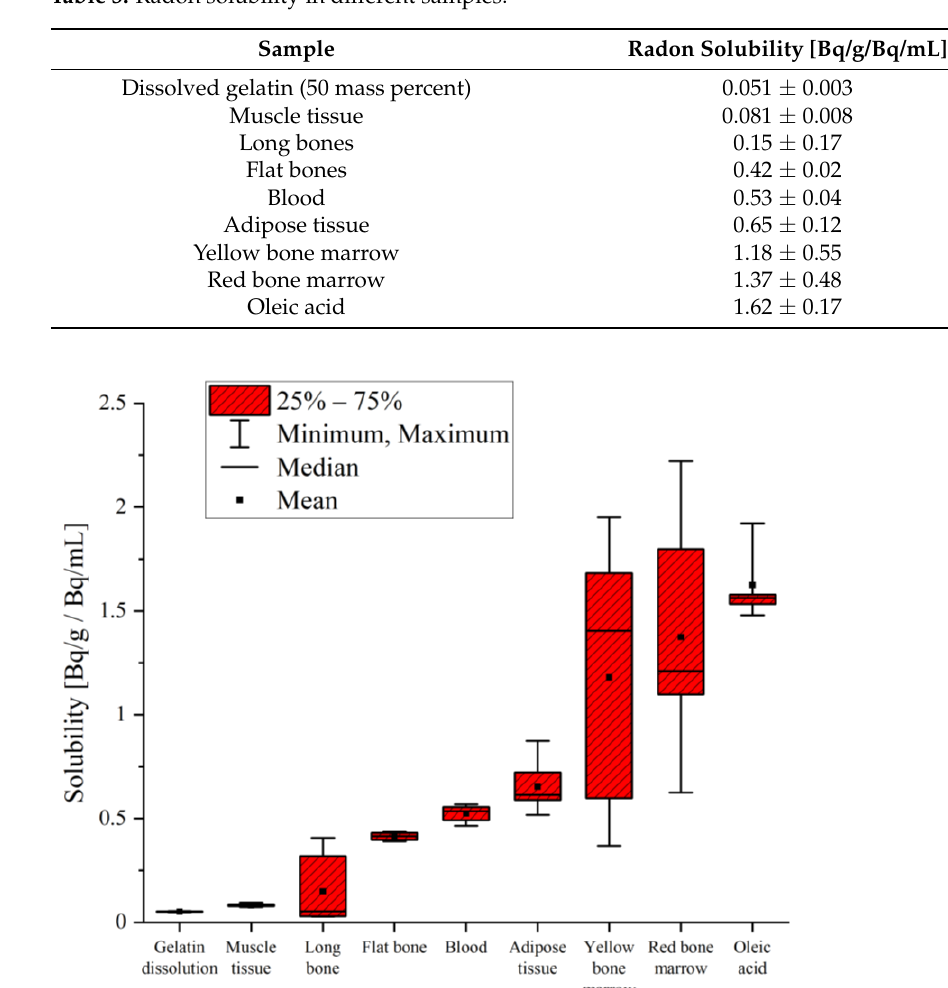
Figure 3. Radon solubility measured in different samples and at different radon activity concentration during the experiment. Experiments were performed at a temperature of 295.5 ± 0.5 K and at an air pressure of 1001 ± 7 mbar (with standard deviation). Bone, dissolved gelatin, muscle tissue and adipose tissue data were obtained using the first exposure protocol. Data for blood and bone marrow were determined with the second exposure protocol. Oleic acid was exposed and measured using both protocols.